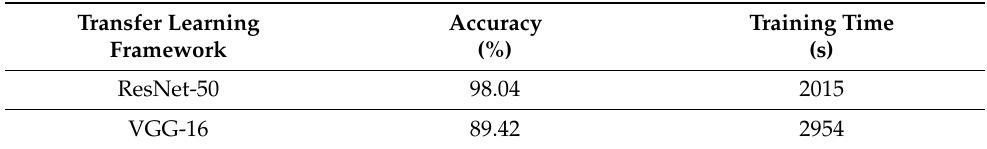
Table 6. Summary of the validation accuracy and training time.